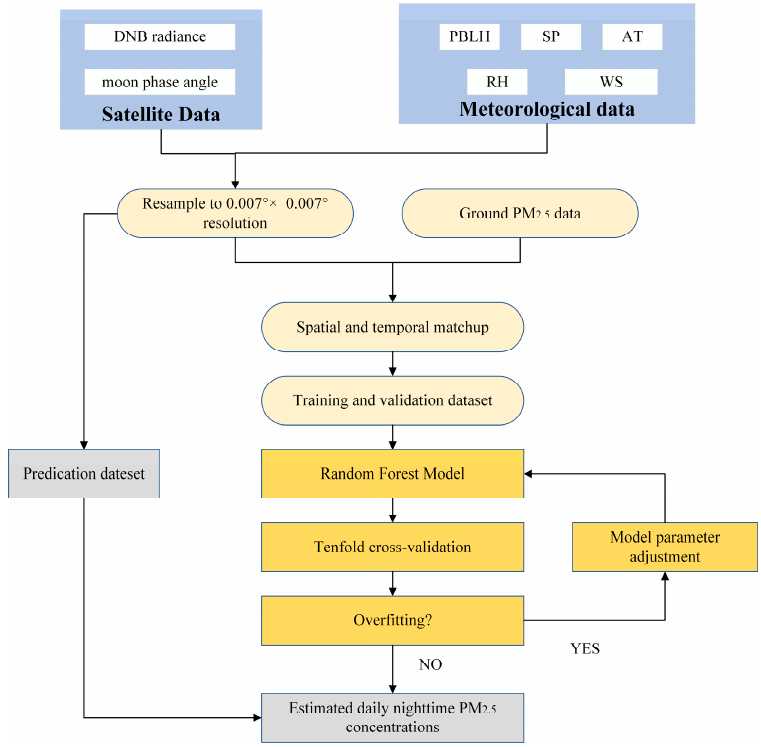
Figure 3. Flow chart of study procedure.